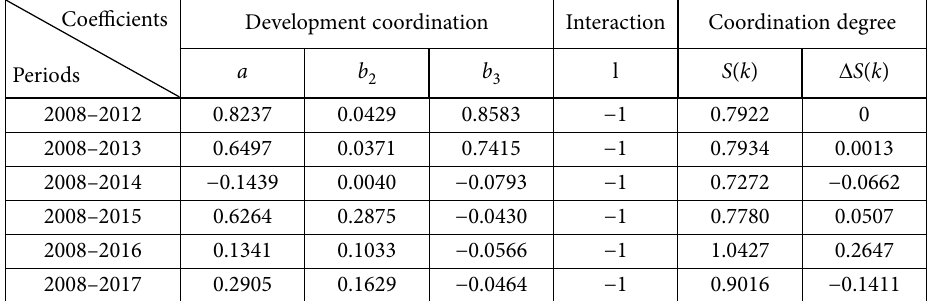
Table 6. Results of CFGM(1,N)